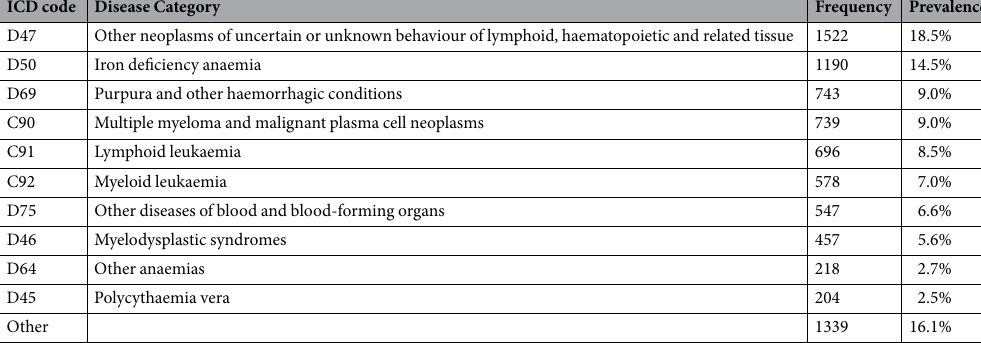
Table 1. Top ten most prevalent categories of diseases in UMCL, Division of